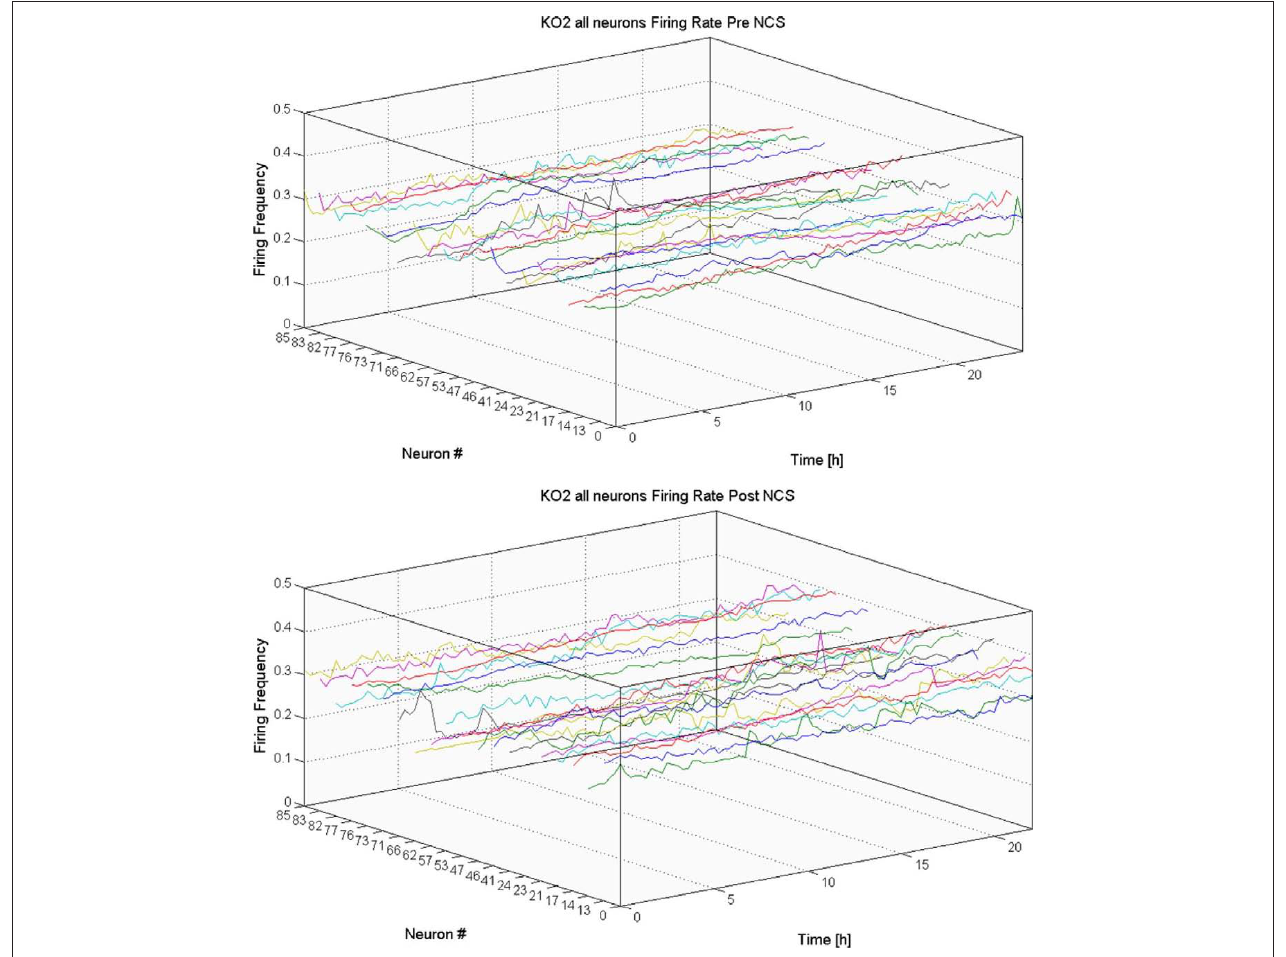
Figure 3 | Firing activity of individual neurons. In this figure we examine the firing rate of each electrode individually for a given culture, before introducing Neocarzinostatin (above), and after (below). We note that the firing rate remains